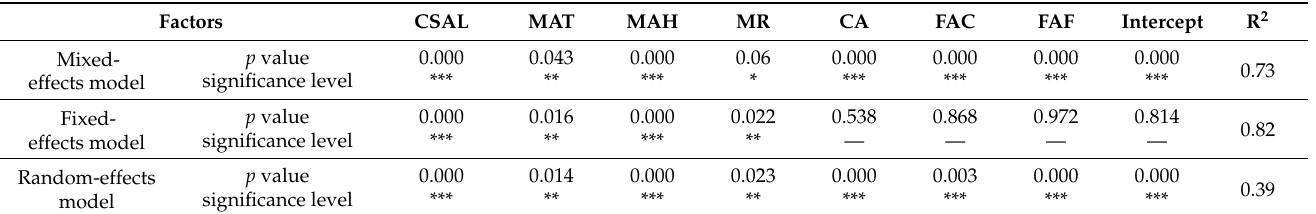
Table 6. Regression results of panel data analysis-based surface texture prediction model using the first 3 years SMTD panel data.